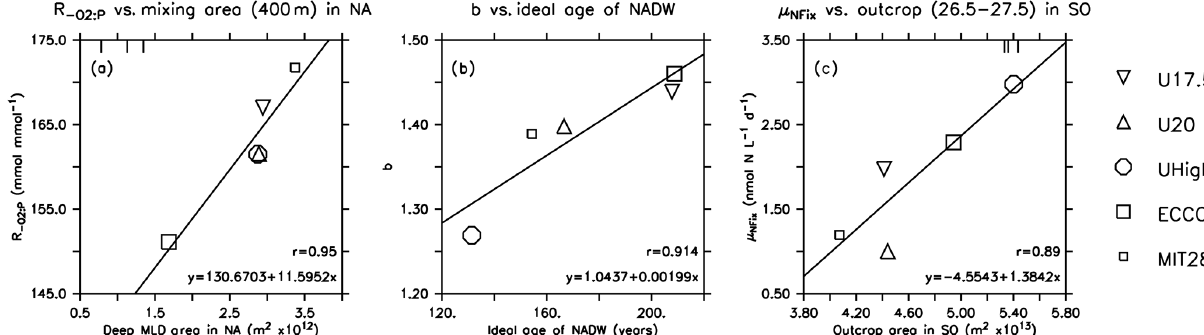
Figure 6. Optimal parameters for which the correlation of Table 2 is significant at p < 0 . 05, plotted against physical diagnostics. Symbols indicate the different model optimisations. Small squares: MIT28 ∗ . Large squares: ECCO ∗ . Circles: UHigh ∗ . Triangles: U20 ∗ . Inverted triangles: U17.5 ∗ . Lines denote the regression of optimal parameters against the respective circulation diagnostic. Vertical bars at the upper plot boundary indicate observed diagnostics. Table 2. Correlation coefficient r for the regression of three optimal model parameters against physical diagnostics. The outcrop area of dense waters in the Northern Hemisphere ( > 40 ◦ N) and Southern Hemisphere ( > 40 ◦ S) is given for two different density intervals. Outcrop area for deep mixing in the North Atlantic ( > 40 ◦ N) and Southern Ocean ( > 40 ◦ S) is given for two different criteria of maximum deep mixing (200 and 400m). Mean water mass age is given for four different water masses. See text for further details. Significant correlations ( p < 0 . 05) are denoted in bold. Parameter Physical diagnostic Area MLD North Atlantic Area MLD Southern Ocean 200m 400m